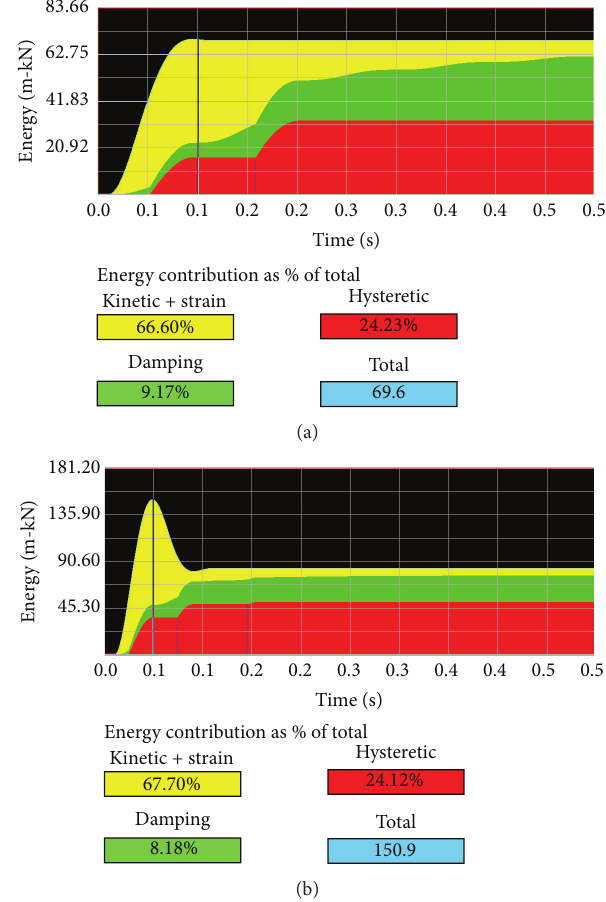
Figure 7: Blast load with a 6m explosion: (a) uncorroded shear wall and (b) corroded shear